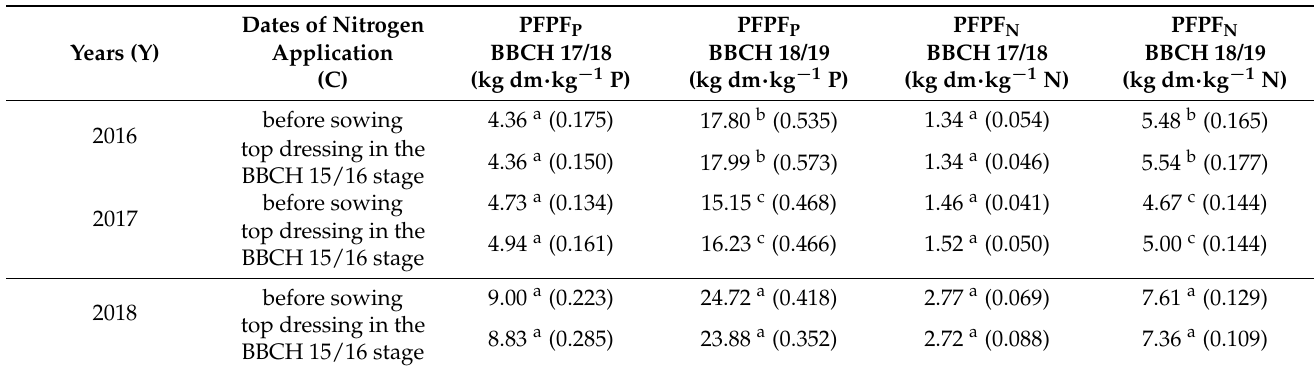
Table 10. Mean values of the traits for the years (Y) and NP fertilizer sowing depth (A), type of supplementary nitrogen fertilizer (B), date of supplementary nitrogen fertilization (C). Years and